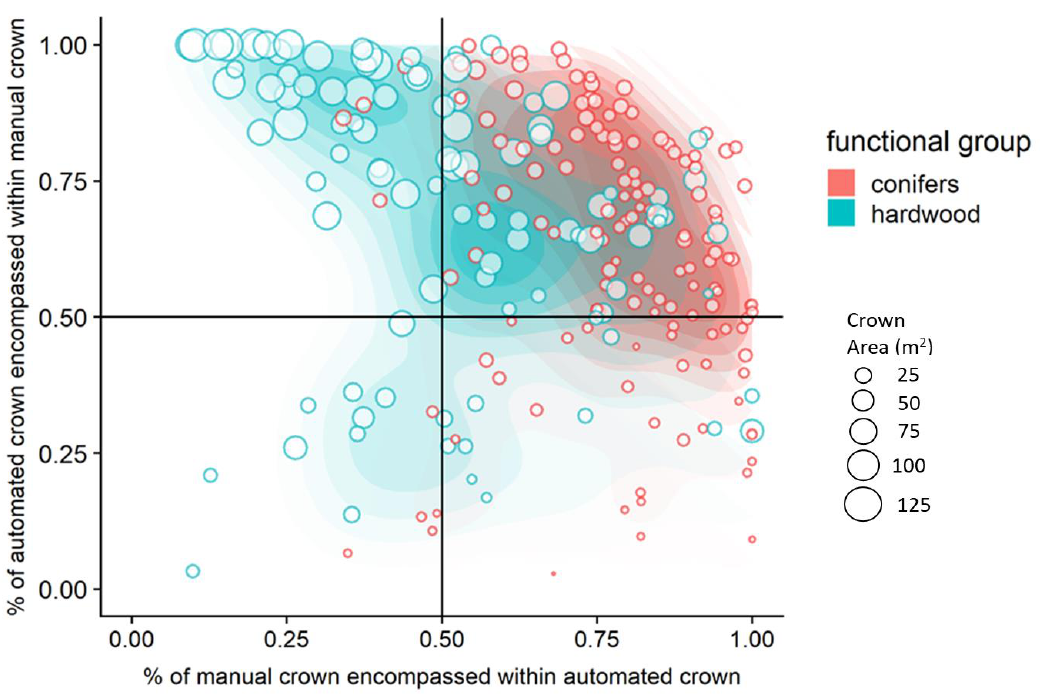
Figure 6. Two-dimensional density plot showing different patterns of crown delineation accuracy between conifer and broadleaf functional groups. The circles provide crown size comparison for two end member species: red pine (shown in red circles) and red oak (shown in blue circles). This figure corresponds with delineation categories described in Figure 3: the top right quadrant signifies true delineations, the top left signifies over-segmentation, the bottom right signifies under-segmentation, and the bottom left signifies false positive. This figure shows data generated using the DALPONTE method, although all methods produce similar patterns.